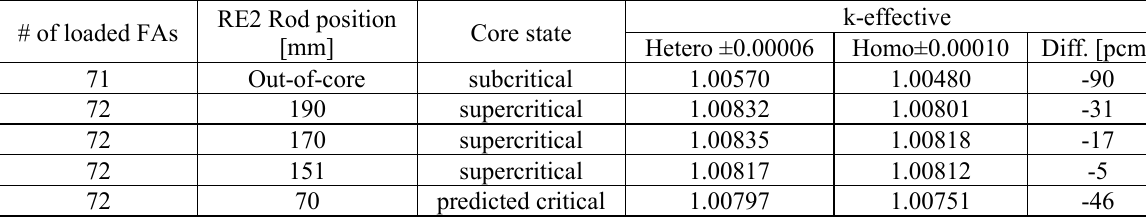
Table 2. Criticality test